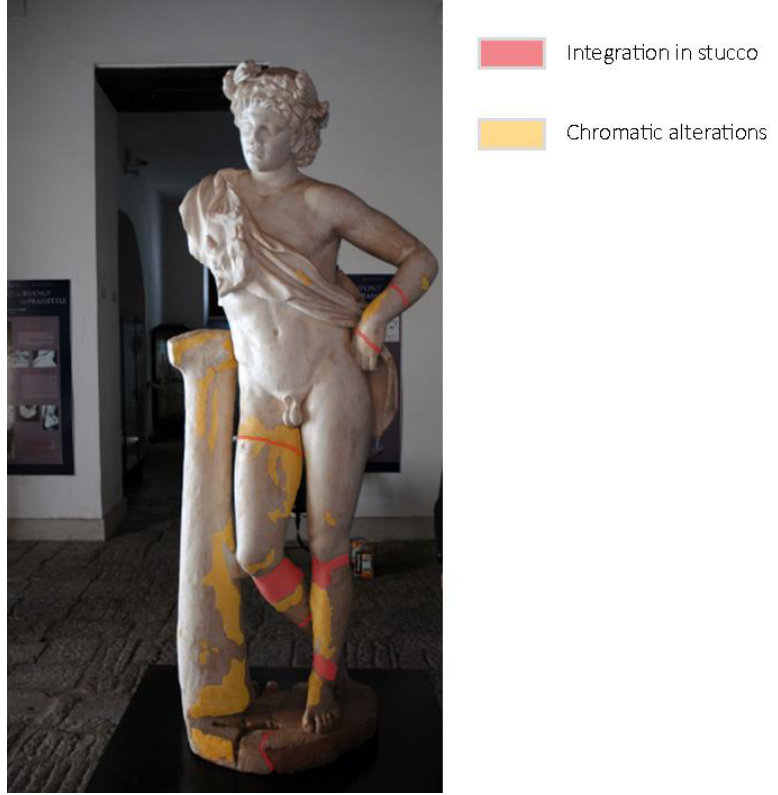
Figure 18. The Resting Satyr , current state, and alteration